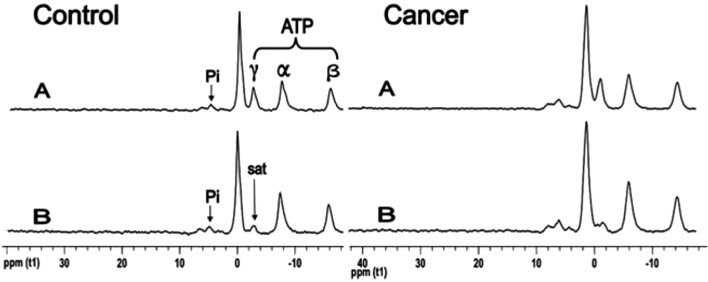
NMR spectra of in vivo
31P NMR saturation-transfer performed on the hind limb skeletal muscle of awake mice. Representative summed 31P-NMR spectra acquired from C and TB mice before (A) and after (B) saturation of the γ-ATP resonance. The arrow on γ-ATP indicates the position of saturation (sat) by rf irradiation (−2.4 ppm). ppm, chemical shift in parts per million.